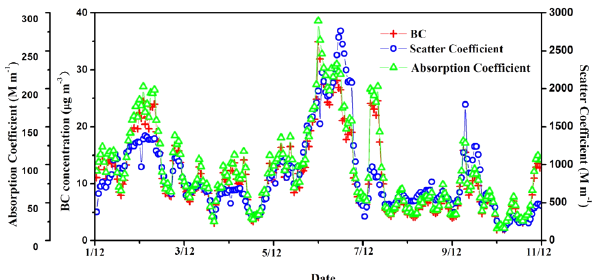
Figure 4. Temporal variations of black carbon (BC) concentration, aerosol scattering (Sc) and absorptive (Ab) coefficients from 1 to 10 December